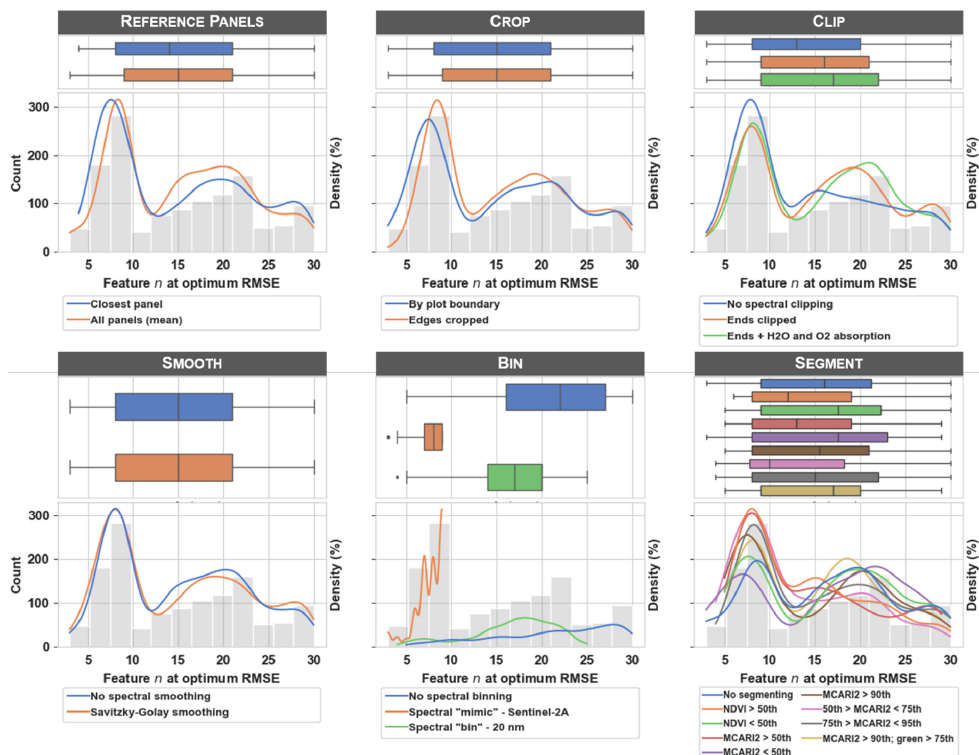
Figure A3. Box plots and density estimates illustrating the number ( n ) of spectral features used to reach the optimum cross-validated root mean squared error (RMSE) for the image processing steps evaluated in this study. At each processing step, the box plots and density estimates illustrate the spread of feature n to reach the optimum error for predicting maize nitrogen uptake (kg ha − 1 ) for each of the processing scenarios evaluated (colors indicate the different scenarios within each image processing step). The grey histogram represents the distribution of feature n at optimum RMSE across all processing steps and scenarios (included as a reference). The feature n at the optimum RMSE was calculated for each unique processing scenario based on Lasso and partial least squares supervised regression estimators (RMSE n = 1296).